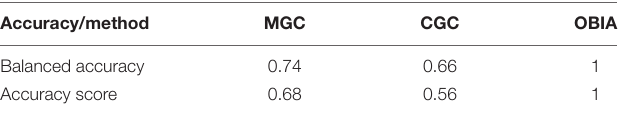
TABLE 1 | Accuracy metrics for Method 1–Multiscale Geometrical Classification (MGC), Method 2–Colour and Geometrical Classification (CGC), and Method 3–Object-based Image Classification